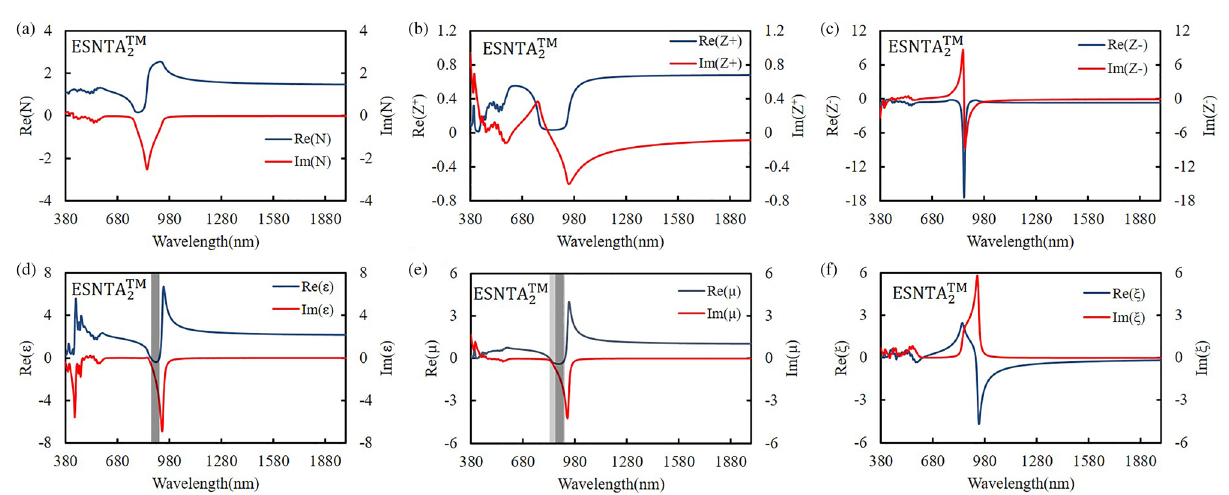
Figure 8. Retrieved ( a ) refractive index, ( b ) positive impedance, ( c ) negative impedance, ( d ) permittivity, ( e ) permeability, and ( f ) bianisotropy parameter for ESNTA 1 TM .